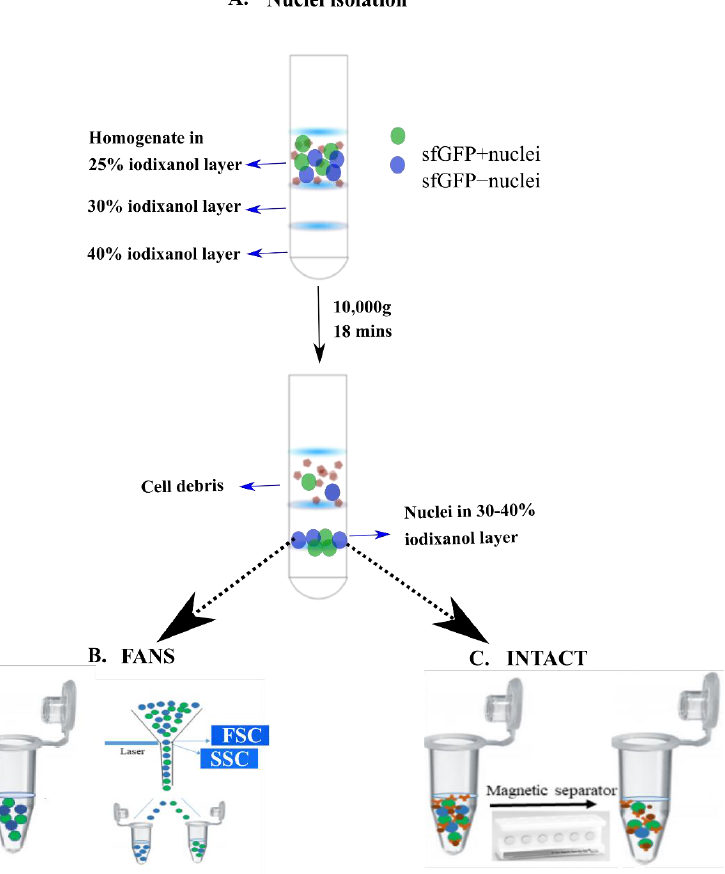
Figure 2. FANS vs. INTACT: Procedural differences and purity estimation: ( A ) nuclei extraction via ultracentrifugation (adapted from Chongtham et al. (2020)); ( B ) nuclei sorting using FANS; ( C ) magnetic separation of bead-bound nuclei using INTACT. Table 1. Processing speed of sfGFP+ nuclei separation using FANS and INTACT (mean of biological